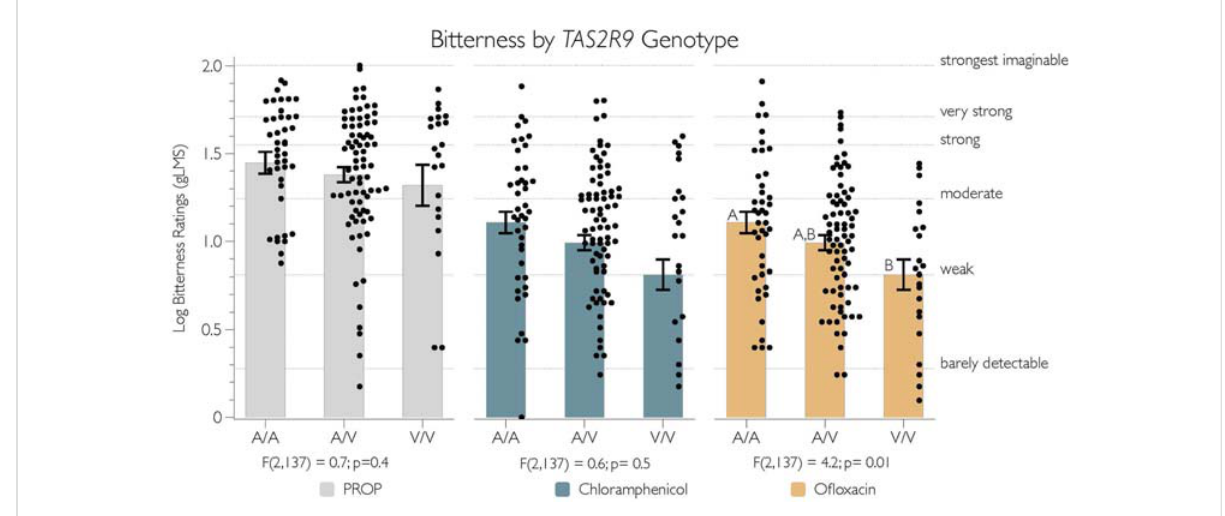
FIGURE 3 The logged bitterness of o fl oxacin is associated with V187A SNP in TAS2R9 . Adjectives on the right y-axis refer to semantic labels on a